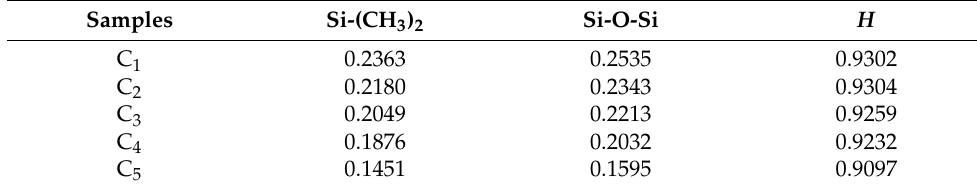
Table 5. The absorption peak height ratio of Si-O-Si and Si(CH 3 ) 2 of composite insulator in C.